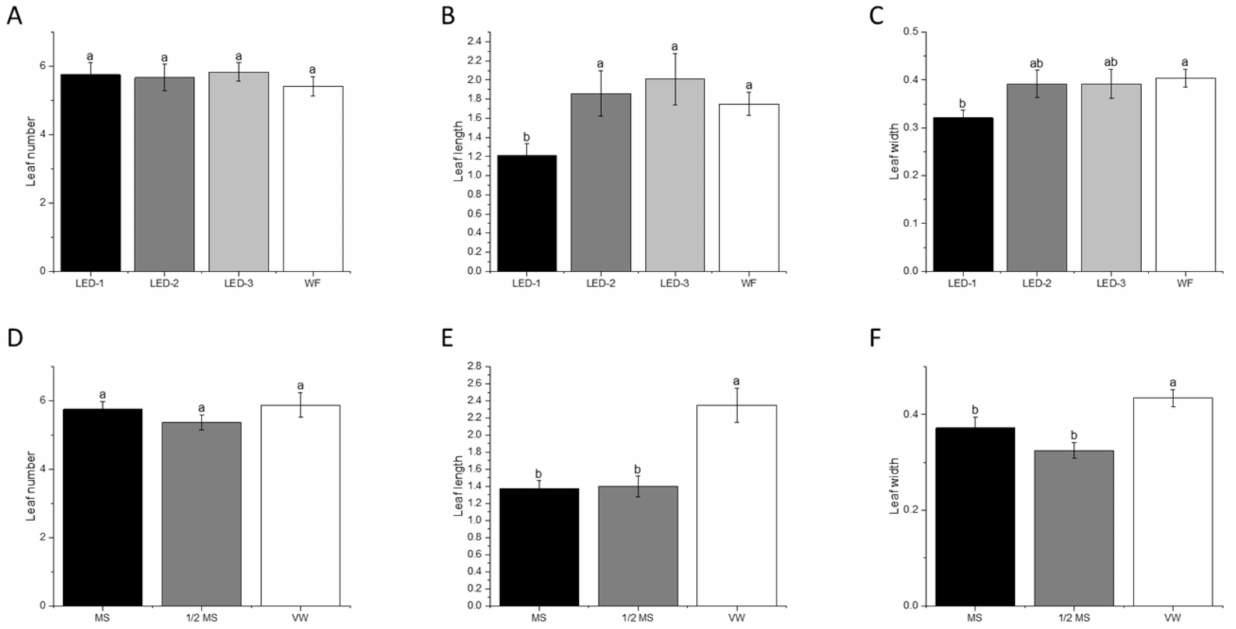
Figure 7. Effects of light sources and culture media on leaf number ( A , D ), leaf length (cm) ( B , E ), and leaf width (cm) ( C , F ) of B. nodosa plantlets during acclimatization for 30 days. LED-1: Light-emitting diode (LED) light with 1575 ± 50 µ mol m − 2 s − 1 Photosynthetic Photon Flux Density (PPFD); LED-2: LED light with 1015 ± 50 µ mol m − 2 s − 1 PPFD; LED-3: LED light with 80 ± 5 µ mol m − 2 s − 1 PPFD; and WF: white fluorescent light with 50 ± 5 µ mol m − 2 s − 1 PPFD. MS: MS basal medium supple- mented with 30 g L − 1 sucrose and 7 g L − 1 agar; 1 / 2 MS: half-strength MS basal medium supplemented with 15 g L − 1 sucrose and 7 g L − 1 ; VW: VW basal medium supplemented with 10% coconut wa- ter, 20 g L − 1 sucrose and 7 g L − 1 . Bars indicate mean ± SE. Different letters indicate significant differences by Tukey’s test at p ≤